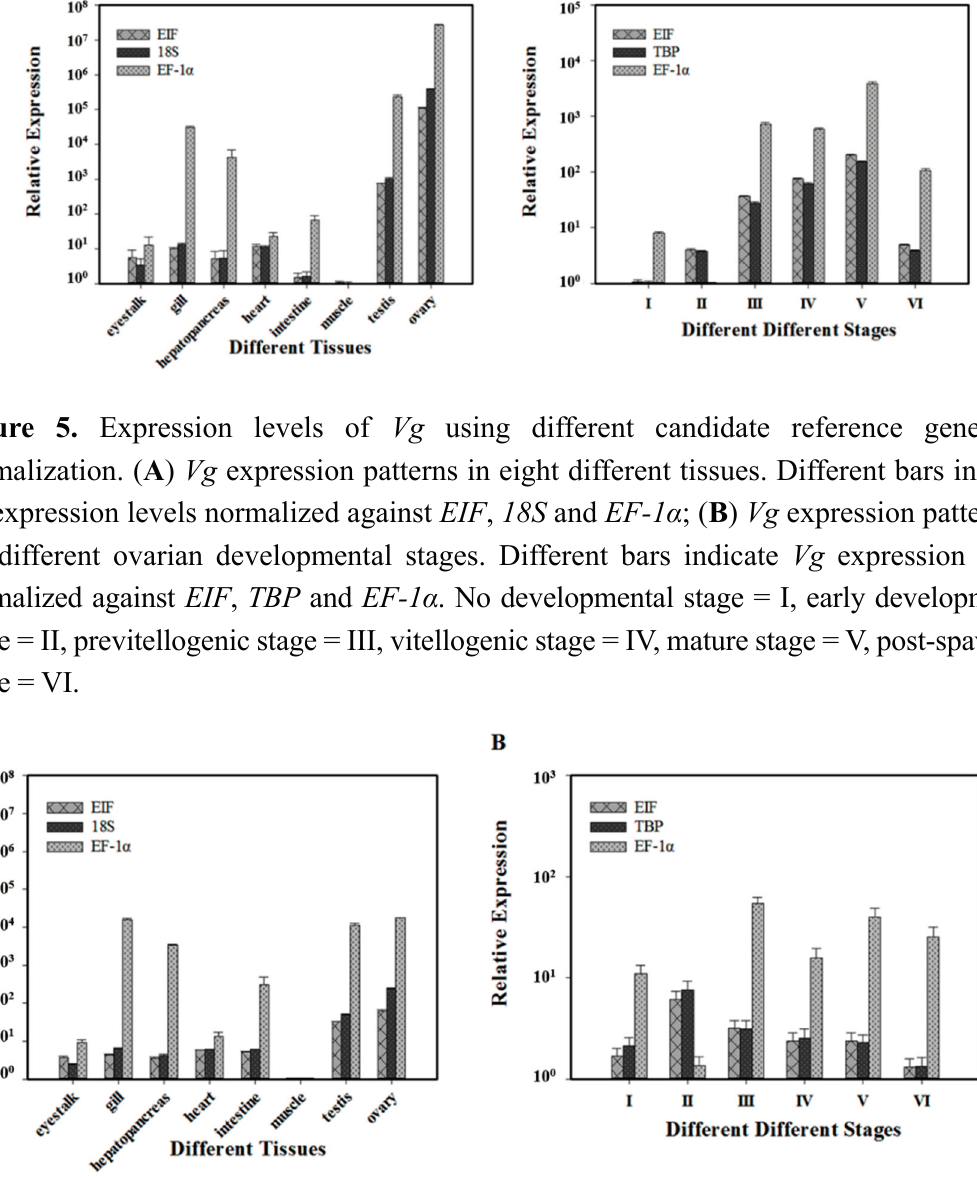
Figure 6. Expression levels of Pcna using different candidate reference genes for normalization. ( A ) Pcna expression patterns in eight different tissues. Different bars indicate Vg expression levels normalized against EIF , 18S and EF-1 α ; ( B ) Pcna expression patterns in six different ovarian developmental stages. Different bars indicate Vg expression levels normalized against EIF , TBP and EF-1 α . No developmental stage = I, early developmental stage = II, previtellogenic stage = III, vitellogenic stage = IV, mature stage = V, post-spawning stage =